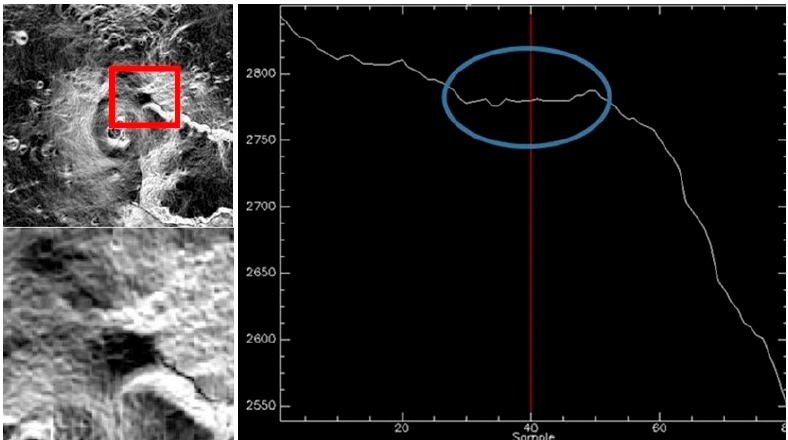
Figure 2. Slope of the PdC area: horizontal profile ( left ); vertical profile in meters a.s.l. ( right ).